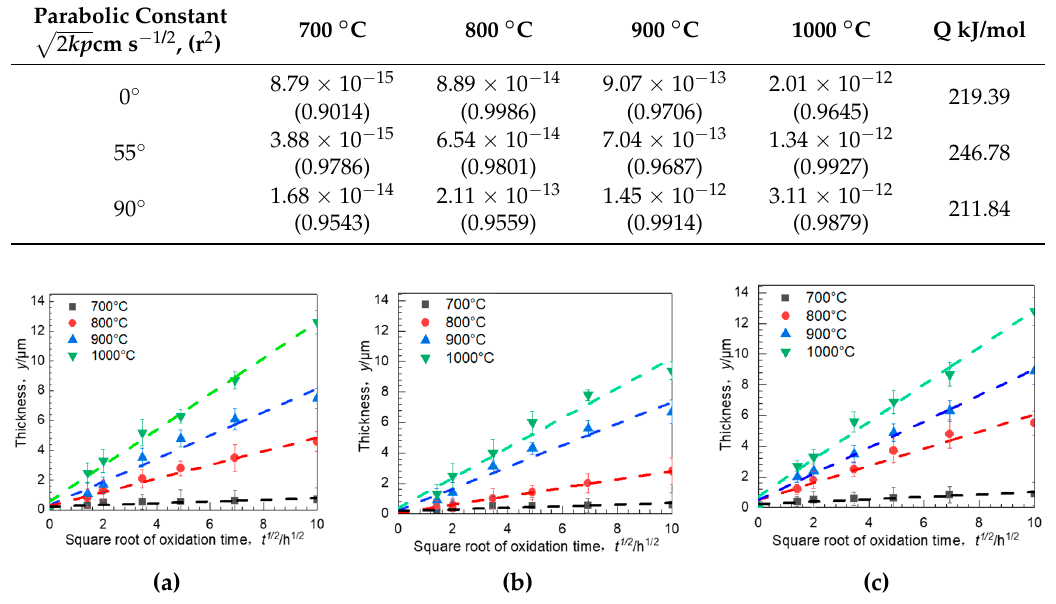
Figure 14. Oxide thickness as a function of oxidation duration for ( a ) 0 ° sample; ( b ) 55 ° sample, and ( c ) 90 ° sample after oxidization at 700, 800, 900, and 1000 °C.